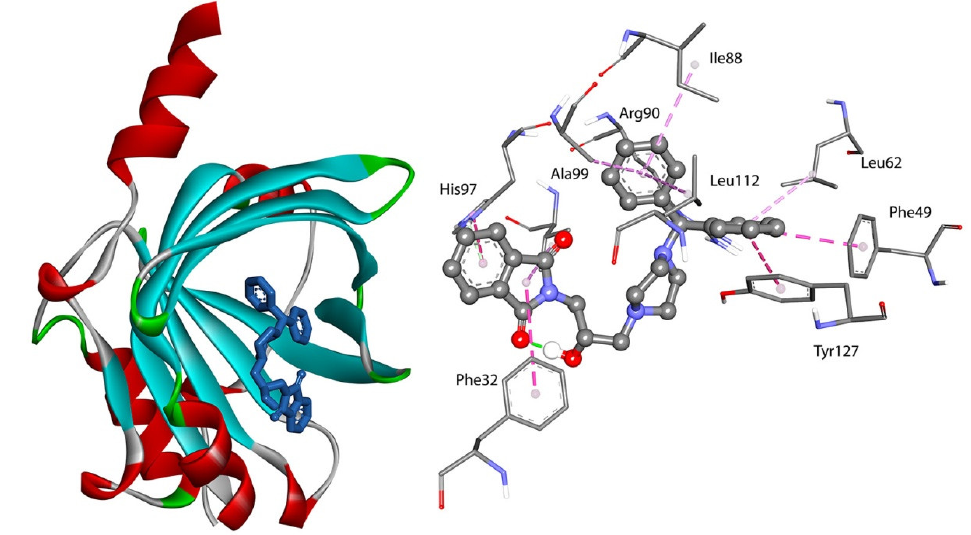
Figure 9. Docked pose and interactions of compound F4 with AAG.